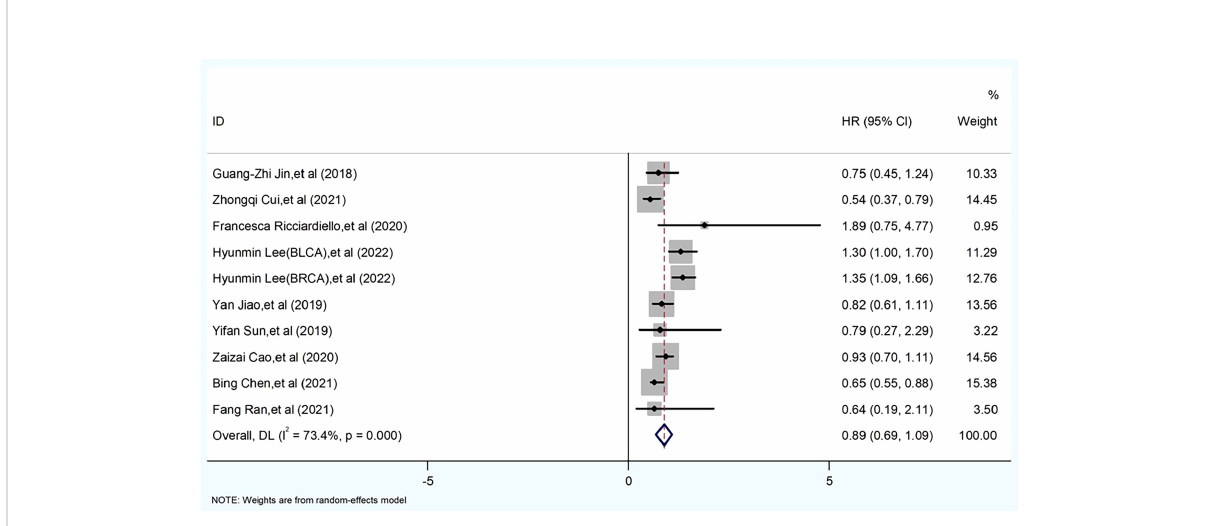
FIGURE 3 Meta-analysis of PGM homologous protein expression pro fi le and survival prognostic risk ratio (HR) in forest